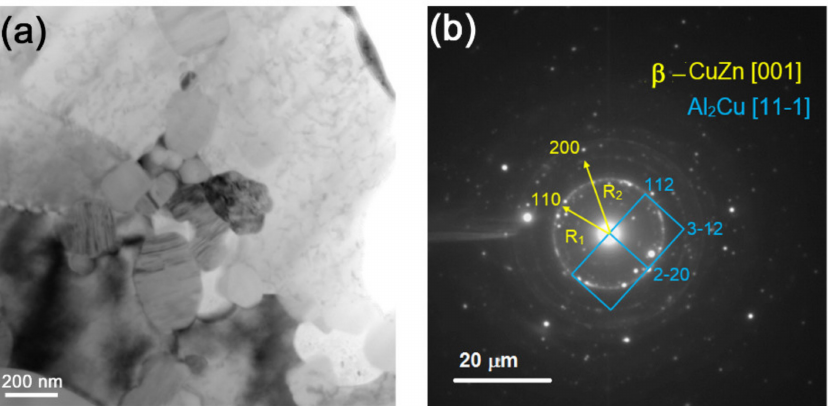
Figure 10. Fine β -CuZn and coarse Al 2 Cu grains ( a ) with corresponding selected area electron diffraction (SAED) pattern ( b ).